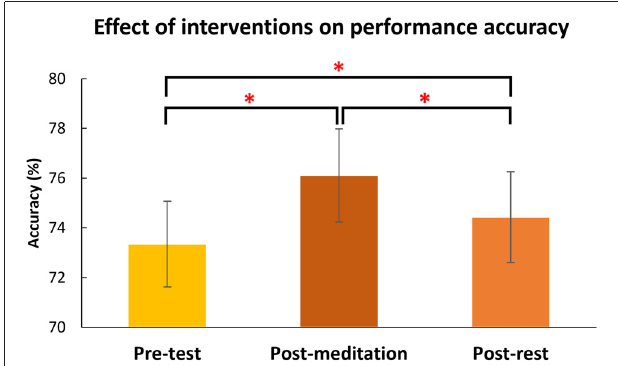
FIGURE 5 | The effect of the interventions on accuracy of the RSVP task. All subjects (across groups and distractor types) performed the RSVP task better after meditation than rest and compared to pre-test. Error bars indicate 95% confidence intervals. The asterisks ( ∗ ) indicate statistically significant differences ( p < 0.05).